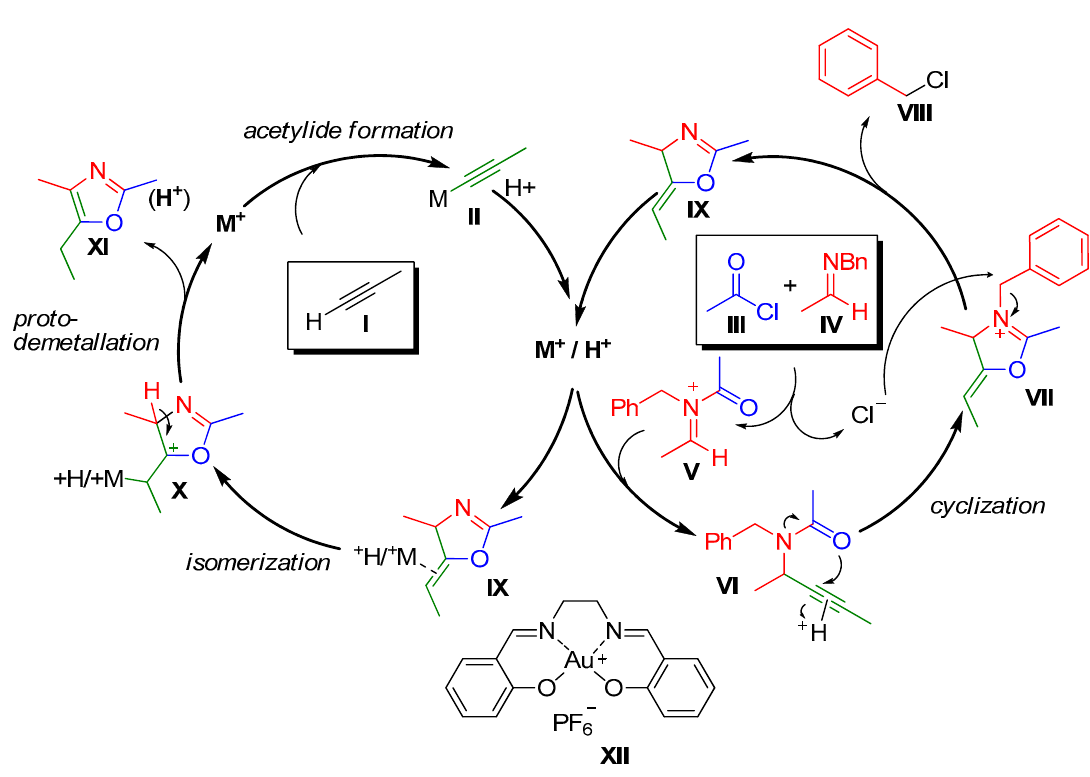
Scheme 9. Proposed mechanism for the gold-catalyzed formation of oxazoles XI .